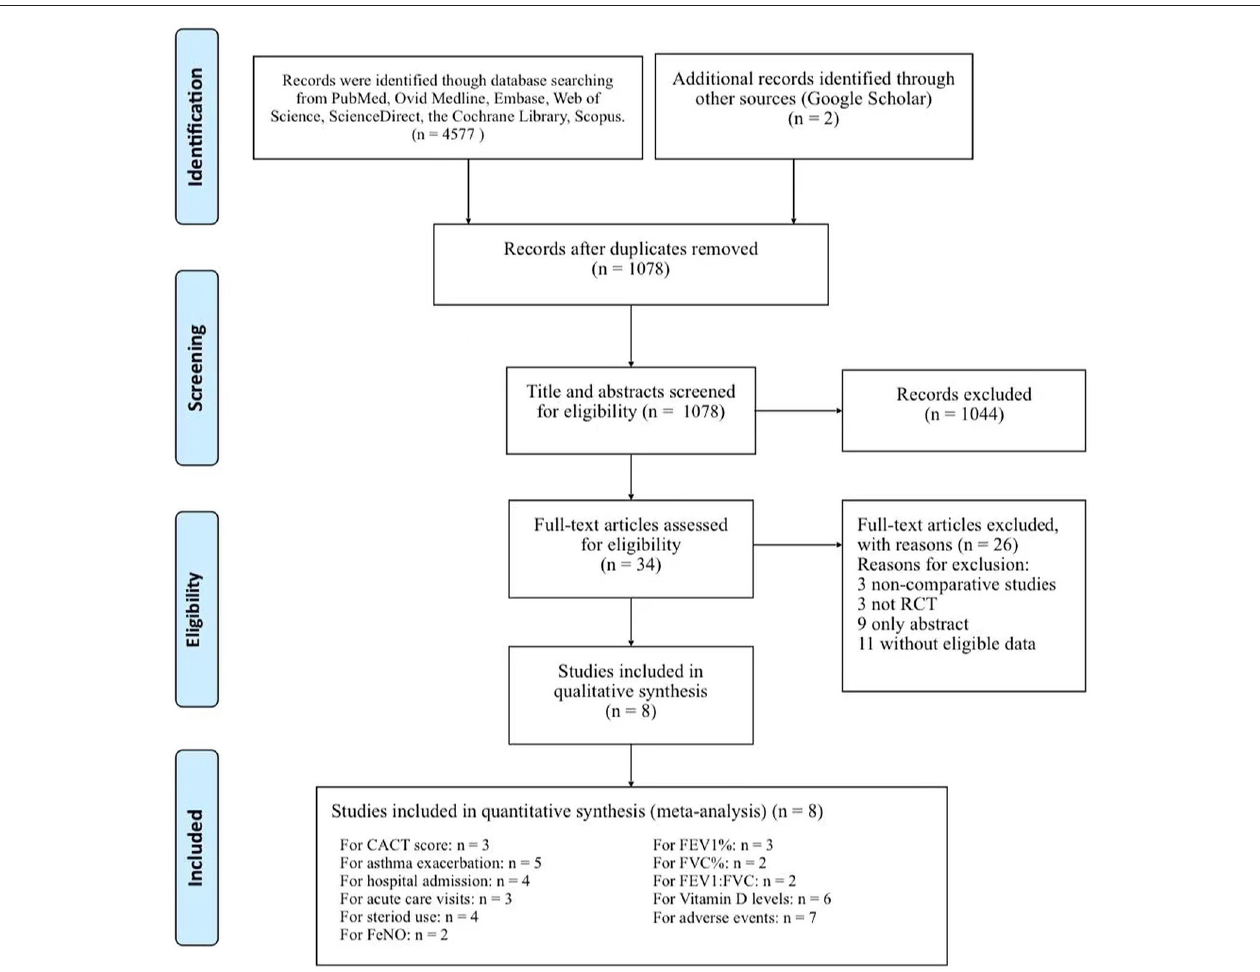
FIGURE 1 | Flow chart of study